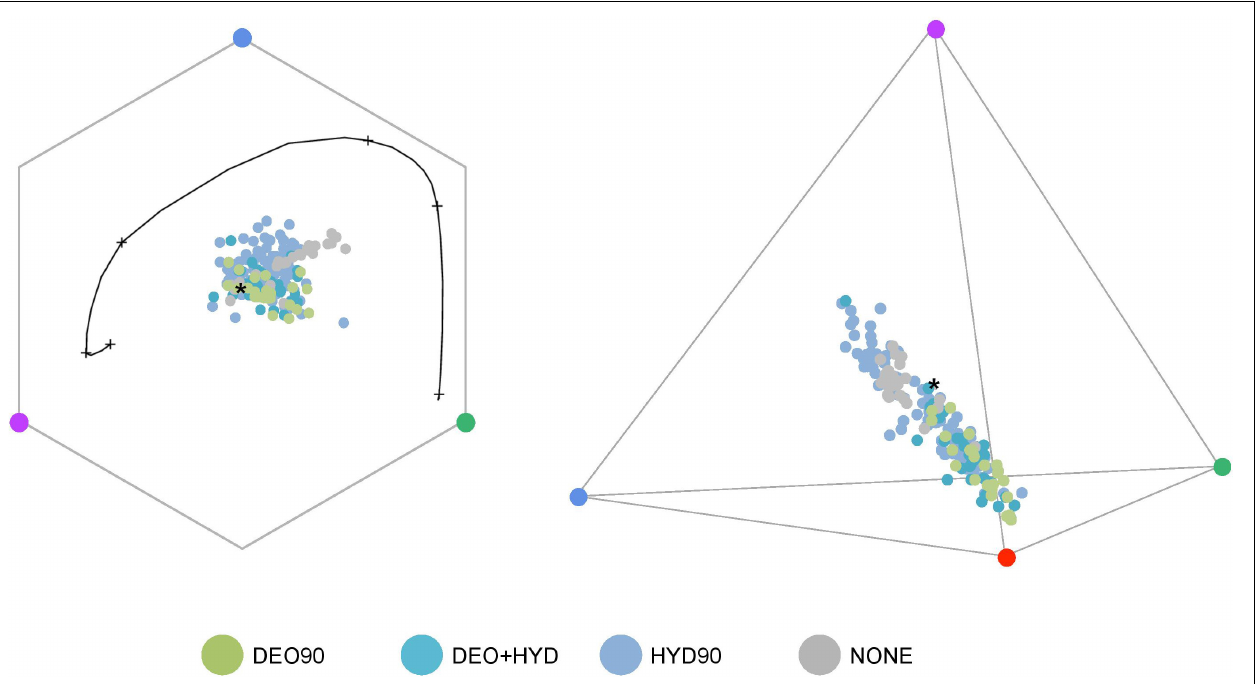
FIGURE 5 | The color loci of Gesnerioideae flowers plotted in bee and hummingbird visual systems. HYD90 ( > 90% HYD; blue), DEO90 ( > 90% DEO; green), DEO+HYD (both DEO and HYD between 10 and 90%; cyan) and no-anthocyanin (NONE; gray) samples are shown in the hexagonal color-space of the bee visual system (left) and the tetrahedral color-space of the hummingbird visual system (right). Colored circles in each corner represents a photoreceptor: UV (purple), blue (blue), green (green), and red (red). * represents the achromatic center of the color-space. The black curve on the hexagonal color-space represents the maximum sensitivity of each photoreceptor to a monochromatic